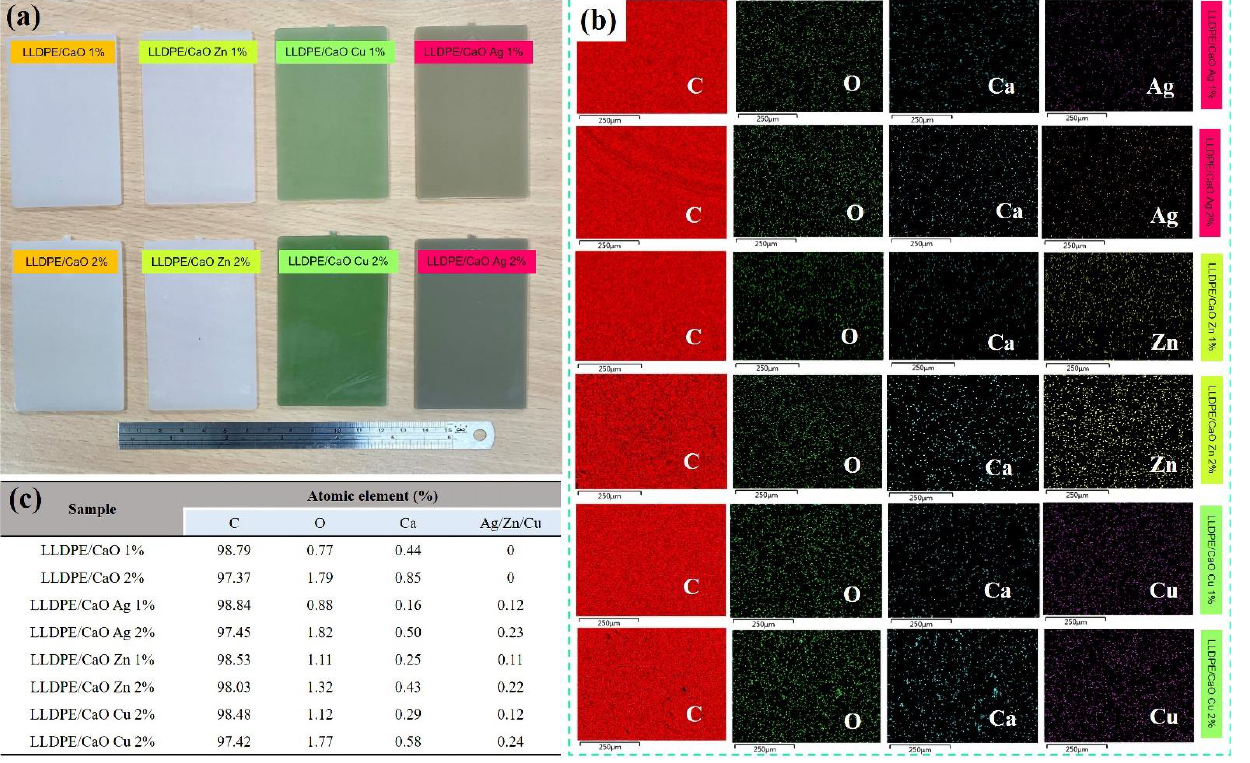
Figure 3. ( a ) Photograph of linear low-density polyethylene (LLDPE) added with different